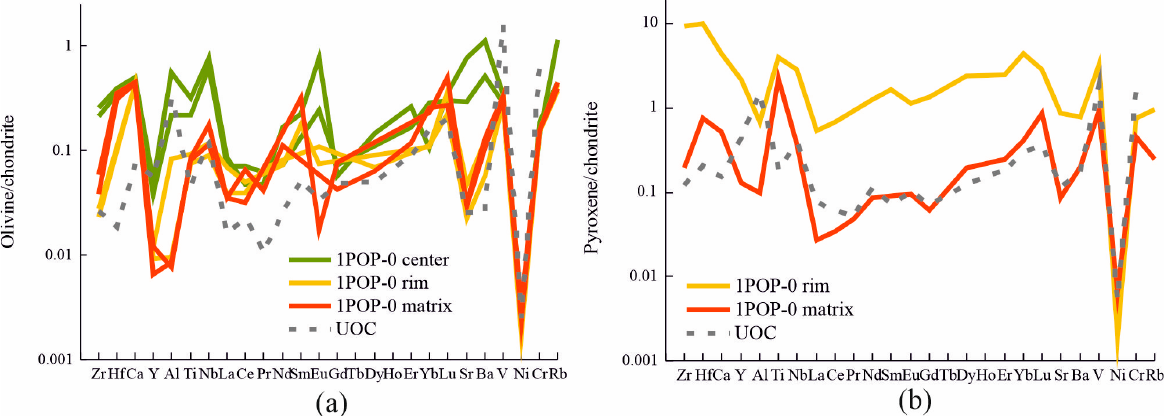
Figure 2. CI chondrite-normalized trace element patterns of olivine ( a ) and pyroxene ( b ) of 1POP-0 chondrule and matrix.